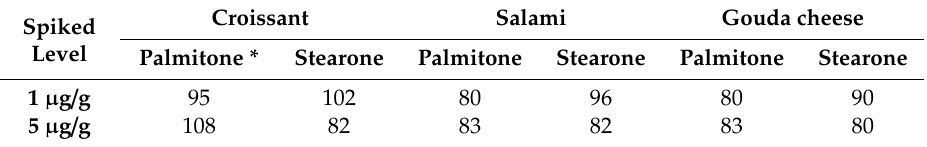
Table 3. Recovery percentages obtained spiking the fat of croissants, salami, and Gouda cheese samples. Croissant Salami Gouda cheese Spiked Level Palmitone * Stearone Palmitone Stearone Palmitone Stearone 1 µ g / g 95 102 80 96 80